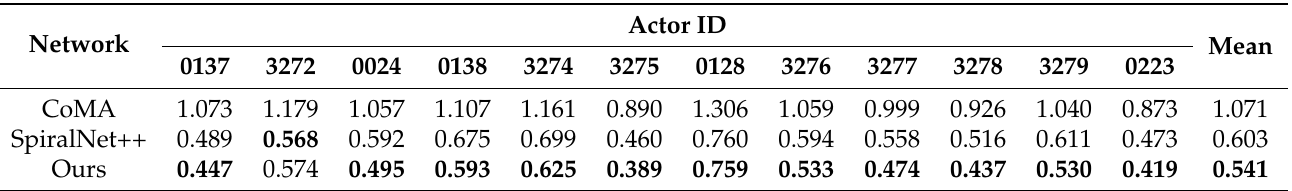
Table 3. Quantitative comparison of shape completion by using different actor models from the CoMA dataset. All the average errors are measured in millimeter